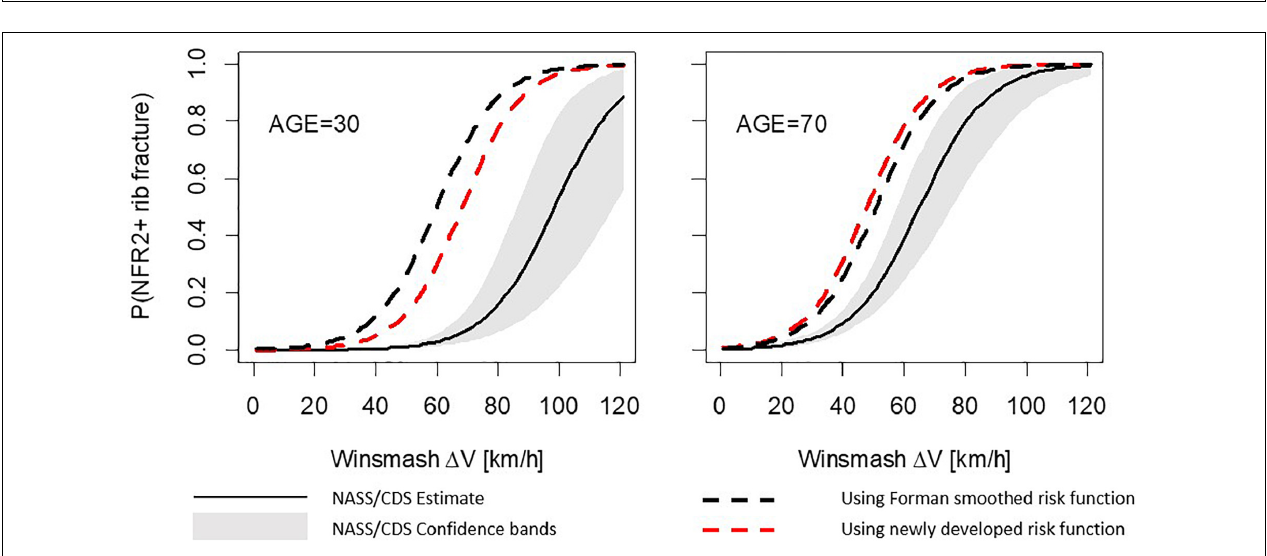
FIGURE 4 | Number of fractured ribs, NFR2 + ; predictions for the frontal stochastic simulations. Comparison between risk curves from probabilistic framework using the Forman smoothed and the newly developed risk functions for a 30-year-old occupant (left) and a 70-year-old occupant (right)